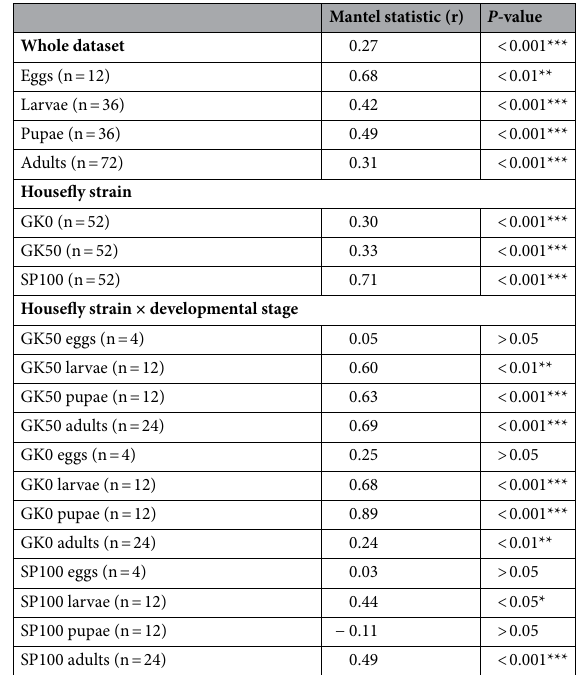
Table 3. Mantel correlations of M. domestica bacterial and fungal microbial communities, based on weighted UniFrac distance